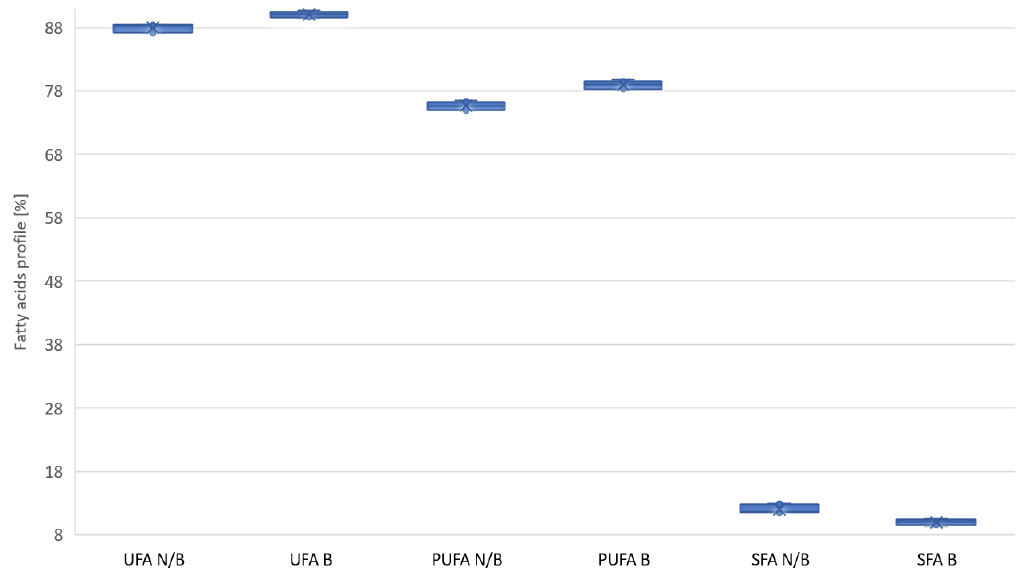
Figure 3. Change in the proportions of SFA, PUFA, and UFA acids after the oil bleaching process. N/B — unbleached oil; B — bleached oil.